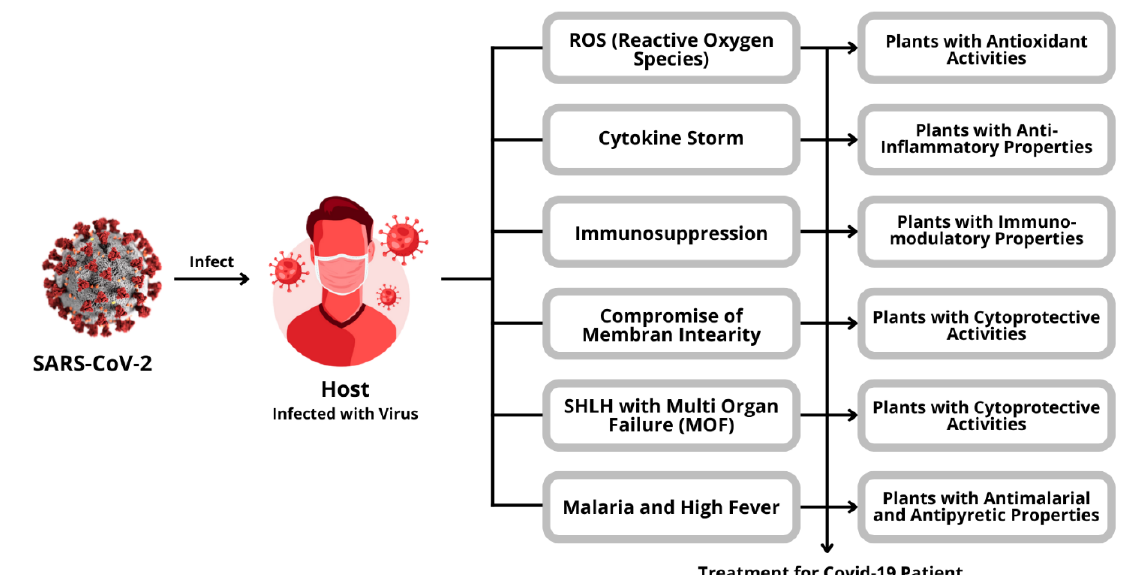
Figure 8. The role of plants in healing COVID-19.